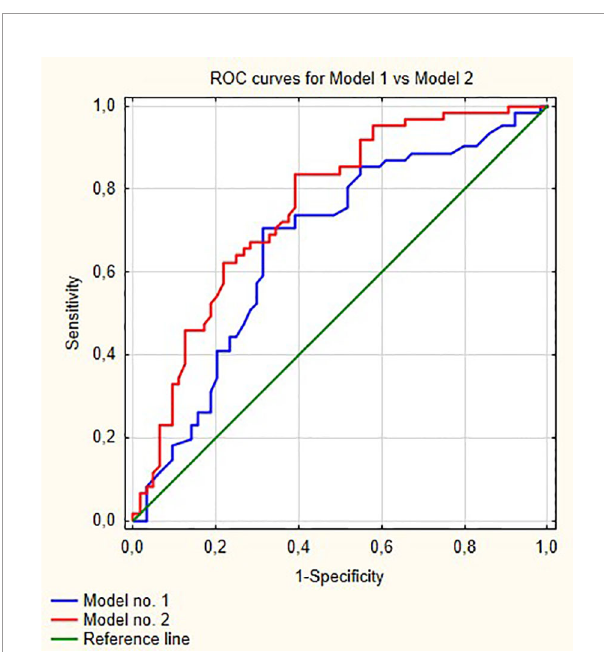
FIGURE 3 | Comparison of ROC curves for models 1 and 4. AUC for model 1 — 0.670; model 2 — 0.676, p = 0.58.